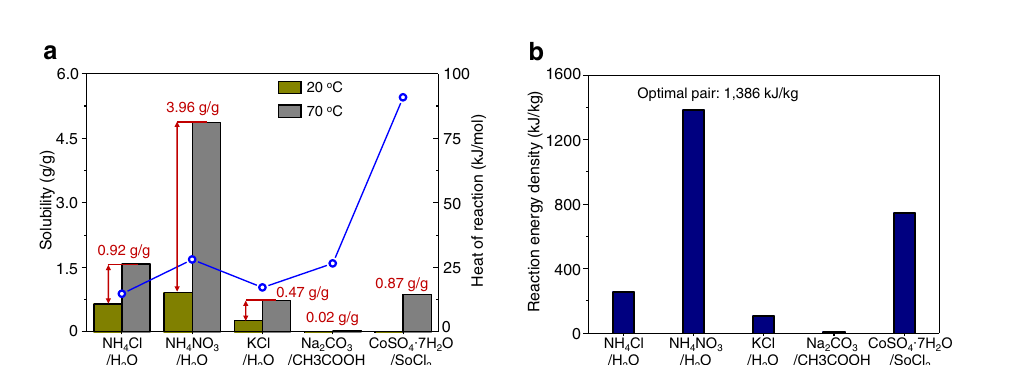
Fig.3|Theoreticalanalysisofendothermicreactionpairsforwaterdesorption-drivenendothermicreaction(WD-ER)cooling.a Idealsolubilityandheatofreaction. b Endothermic reaction cooling energy density. Source data are provided as a Source data fi le.